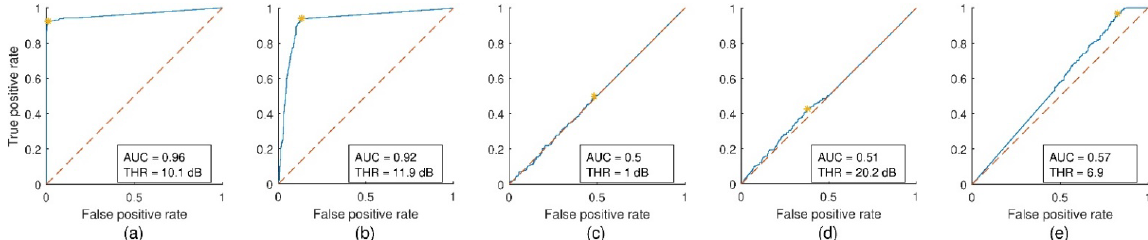
Figure 10. ROC curves regarding binary prediction of implantation recommendation. The used single predictors are as follows: ( a ) the flat component of the IHC loss (I f ), ( b ) the sloping component of the IHC loss (I s ), ( c ) the flat component of the cochlear gain loss (O f ), ( d ) the sloping component of the cochlear gain loss (O s ), and ( e ) the number of active fibers attached to each IHC (N fib ). Yellow asterisks and cut-off thresholds THR were obtained at maximal perpendicular distances of the ROC curves to the lines of equality.